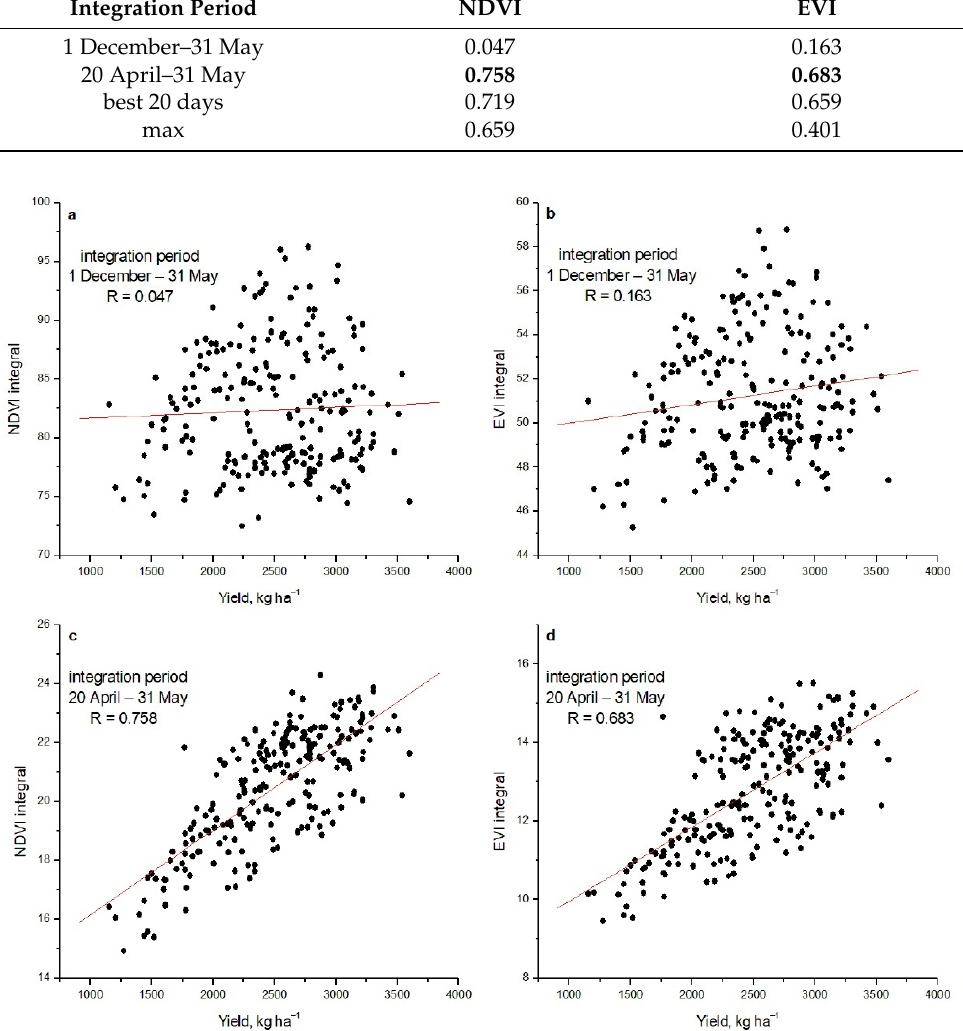
Table 2. Correlation coefficients between final yield and vegetation indices for various integration periods and maximum VI values. Best 20 days integral concerns the 6–25 May period. Data concern the pilot field, corresponding to 221 pixels. Bold numbers denote the highest correlations for each VI. Integration Period NDVI